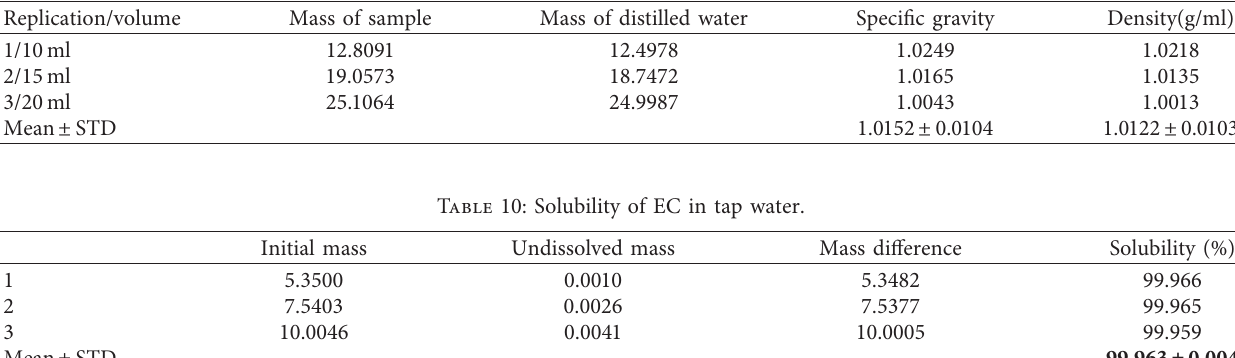
Figure 10: MSE versus the number of epochs in the hidden Table 9: Specific gravity and density of EC.